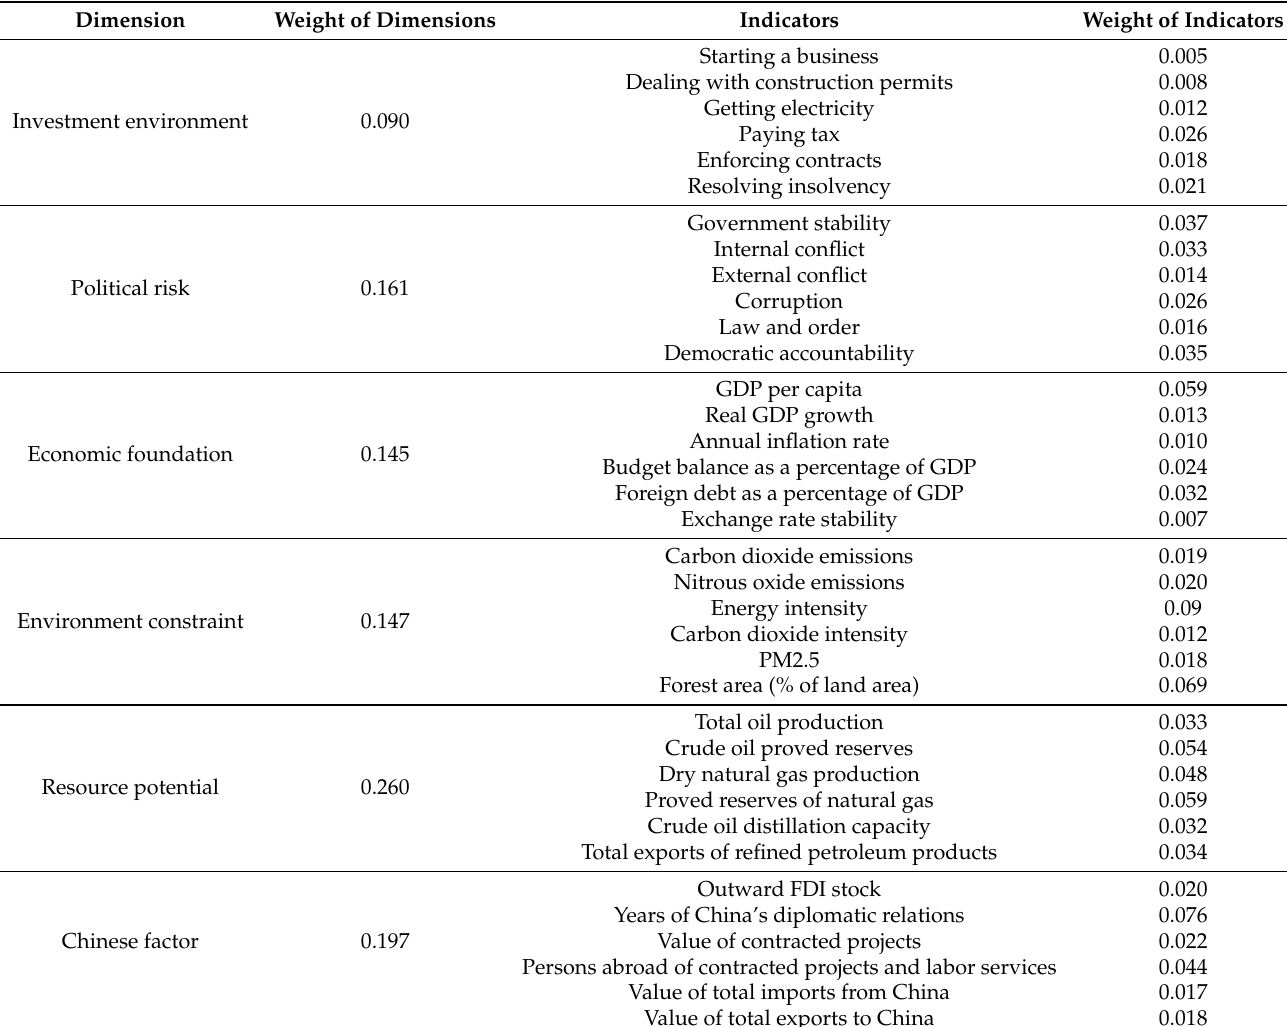
Table 3. Estimated weights of risk evaluation indicators for six dimensions based on the statistics from 2013 to 2019. Dimension Weight of Dimensions